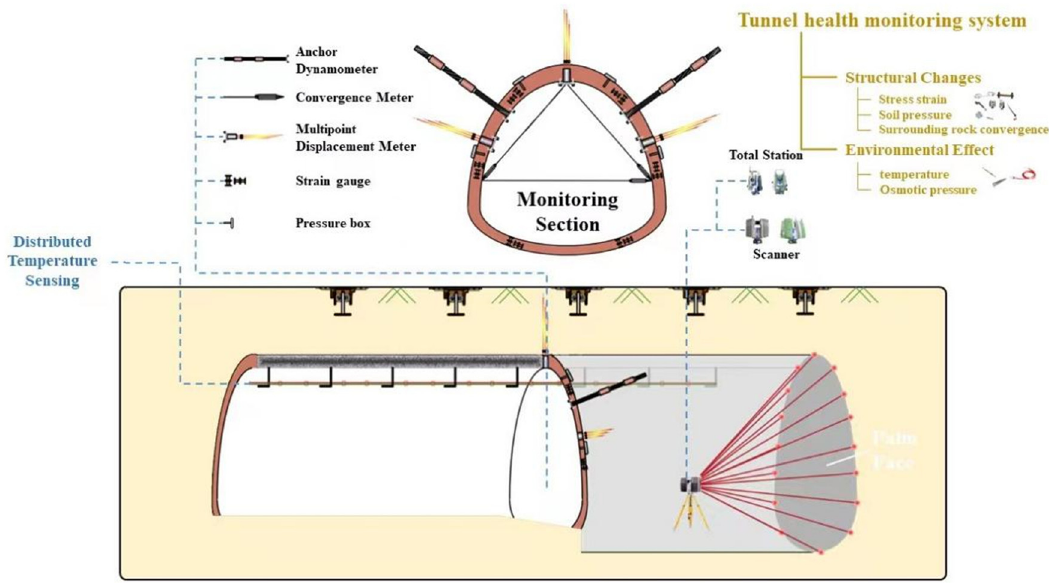
Figure 1: Solution of online monitoring system for tunnel